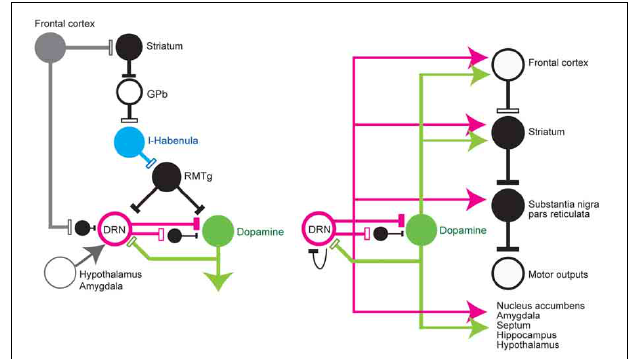
FIGURE 1 | Simplified diagram of input to (left) and output from (right) the dorsal raphé nucleus. DRN, dorsal raphé nucleus; Dopamine, dopamine neurons; l-Habenula, lateral habenula; RMTg, rostromedial tegmental nucleus; and GPb, globus pallidus external and internal border (anatomically called the internal medullary lamina). The open and filled rectangles correspond to excitatory and inhibitory connections, respectively. The arrows indicate that the effect is unknown or excitatory and inhibitory effects have been